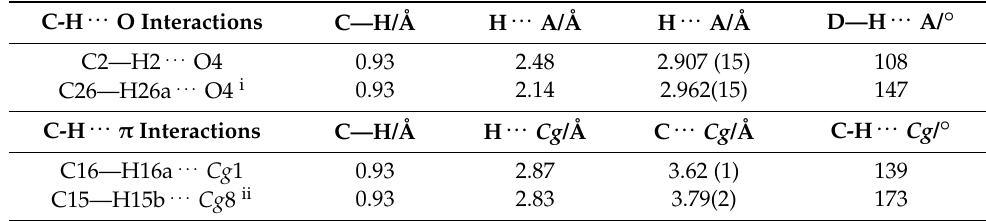
Table 2. Geometrical parameters characterizing the selected intramolecular interactions in structure I .